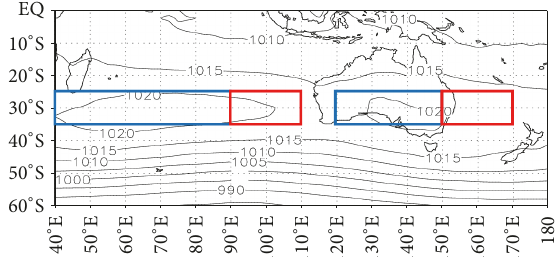
Figure 8: The 30 yr climatology SLP in the prerainy season from 1971 to 2000 (contour). The blue rectangular boxes represent the MH (25 ∘ –35 ∘ S, 40 ∘ –90 ∘ E) and AH (25 ∘ –35 ∘ S, 120 ∘ –150 ∘ E) regions; the red rectangular boxes represent the IEMH (25 ∘ –35 ∘ S, 90 ∘ –110 ∘ E) and IEAH (25 ∘ –35 ∘ S, 150 ∘ –170 ∘ E)